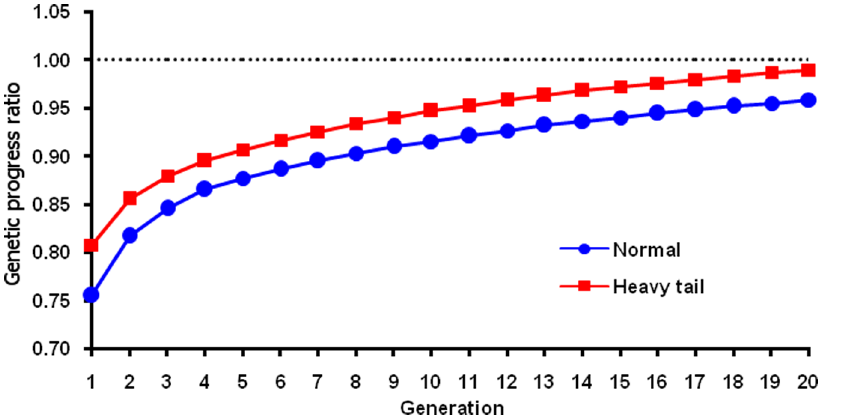
Figure 2. Ratio of adjusted to unadjusted genetic progress by generation for 2 QTL distributions. The ratio was calculated as the genetic progress for a simulated population based on adjusted genomic breeding value from the Jannink [5] formula divided by genetic progress based on genomic breeding value from unweighted selection. A QTL distribution with normally distributed allele effects and a heavy-tailed QTL distribution were tested.